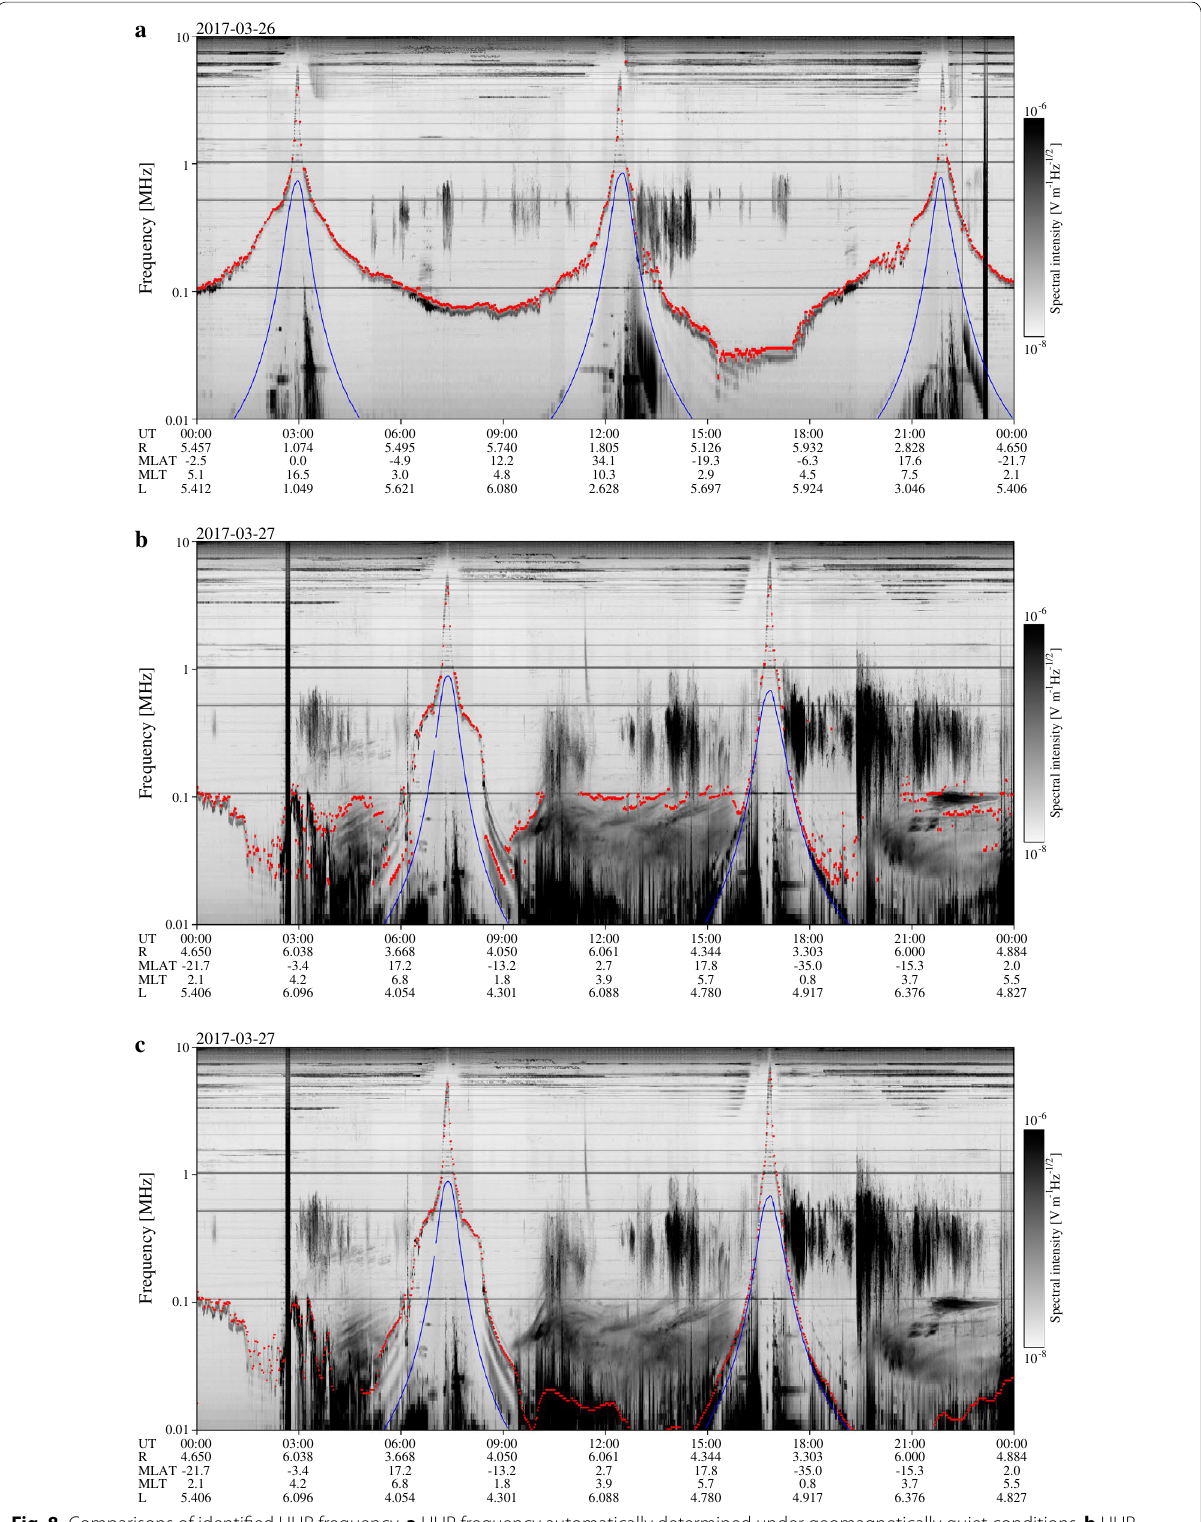
Fig. 8 Comparisons of identified UHR frequency. a UHR frequency automatically determined under geomagnetically quiet conditions. b UHR frequency automatically determined under geomagnetically disturbed conditions. c UHR frequency after the manual correction of that in